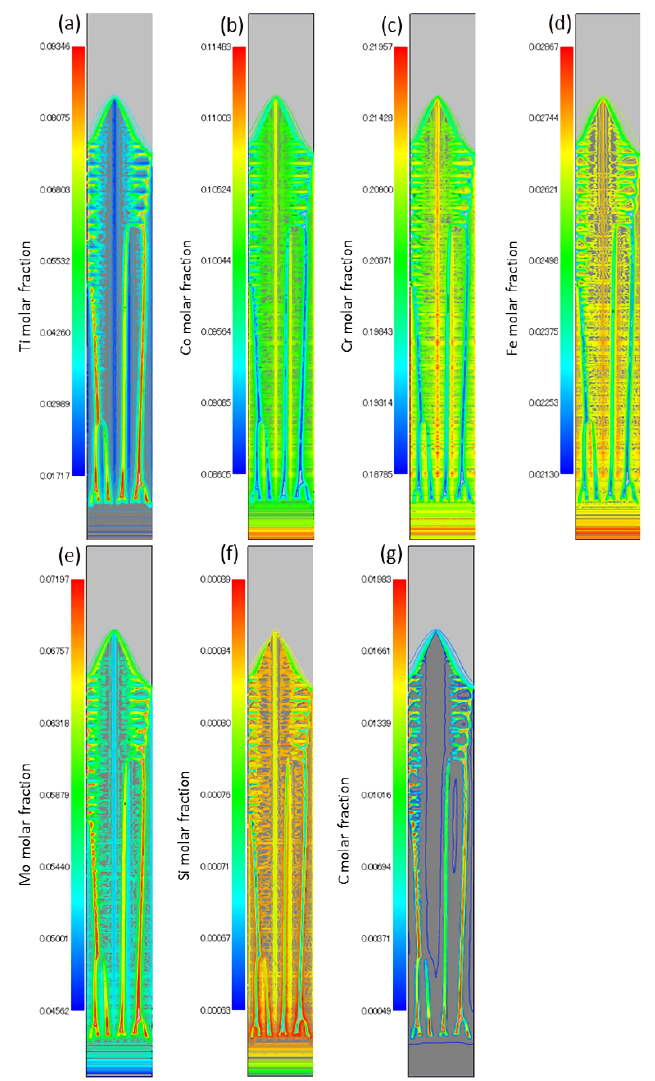
Figure 8. Temporal solute element fraction distributions with phase distributions at the 10-layer position: 10p at 0.54 s, ( a ) Ti, ( b ) Co, ( c ) Cr, ( d ) Fe, ( e ) Mo, ( f ) Si, and ( g ) C.